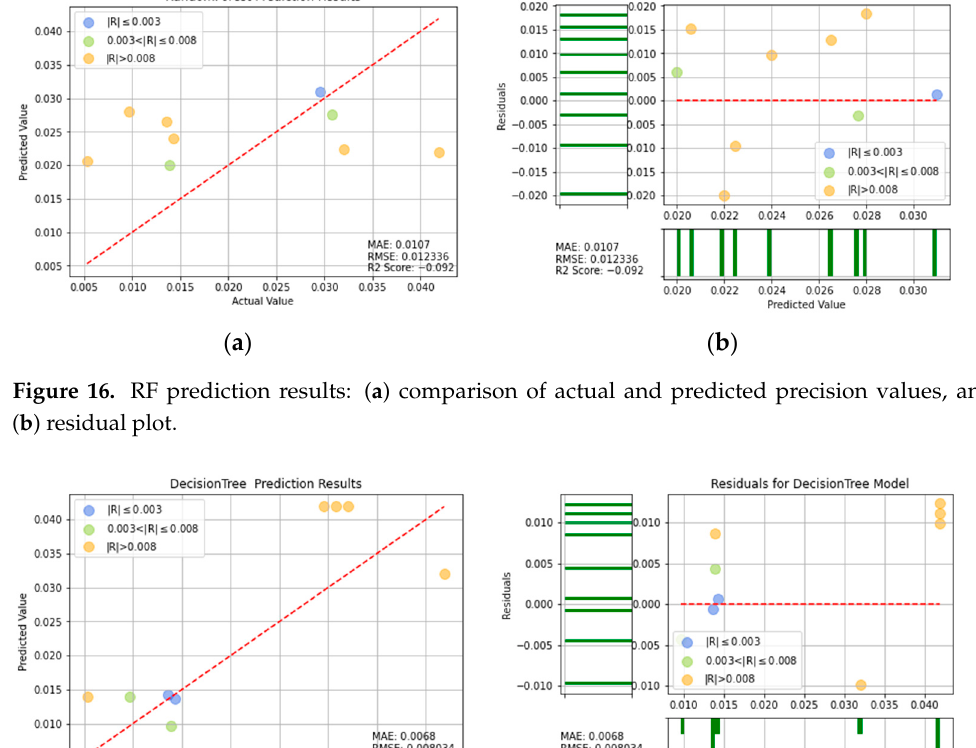
Figure 17. DT prediction results: ( a ) comparison of actual and predicted precision values, and ( b ) residual plot.